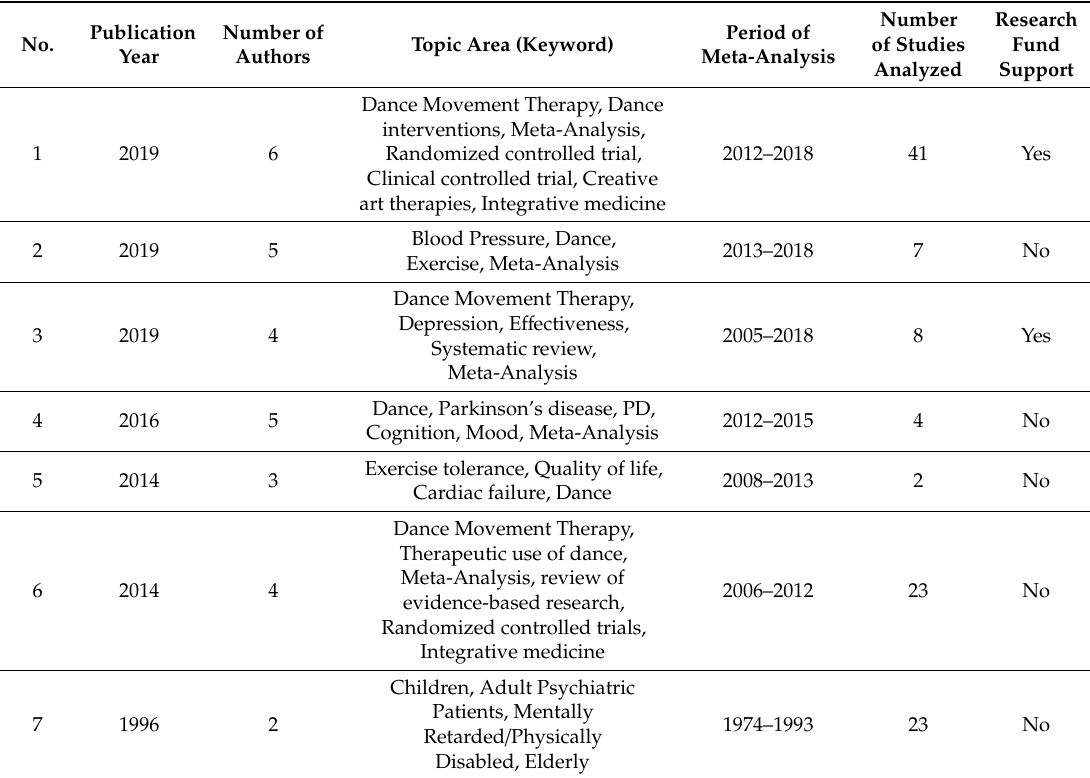
Table 3. Main features of meta-analysis research related to dance therapy